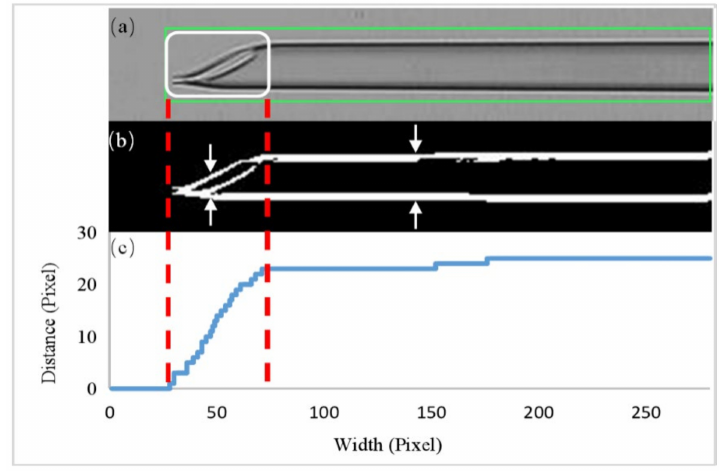
Figure 3. Micropipette detection. ( a ) Original image. ( b ) Binary image obtained by adaptive thresh- olding Otsu method. ( c ) The distance between the upper edge and lower edge of the micropipette.